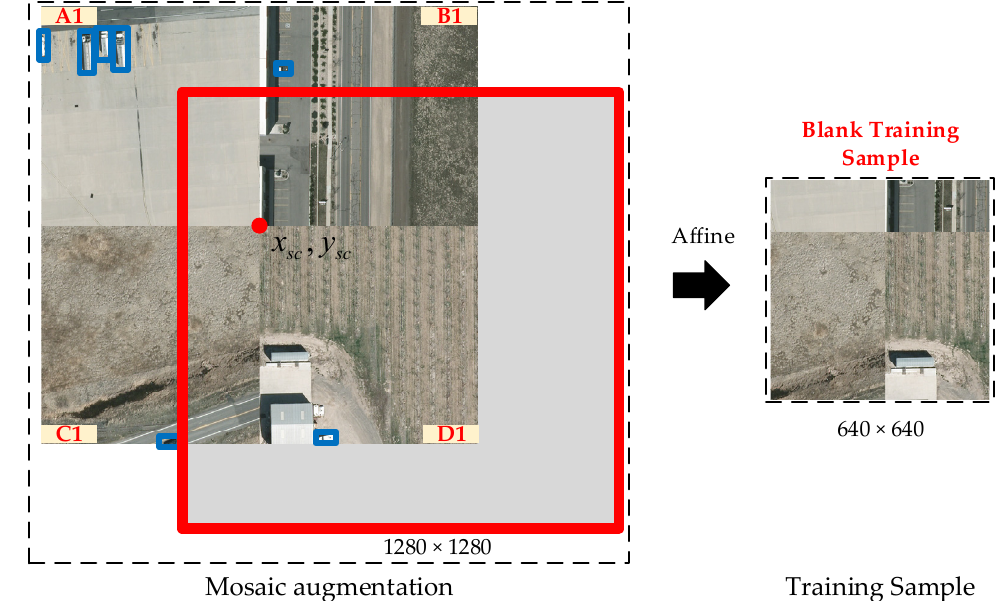
Figure 2. Mosaic augmentation generates training samples by randomly selecting four images and splicing them together.